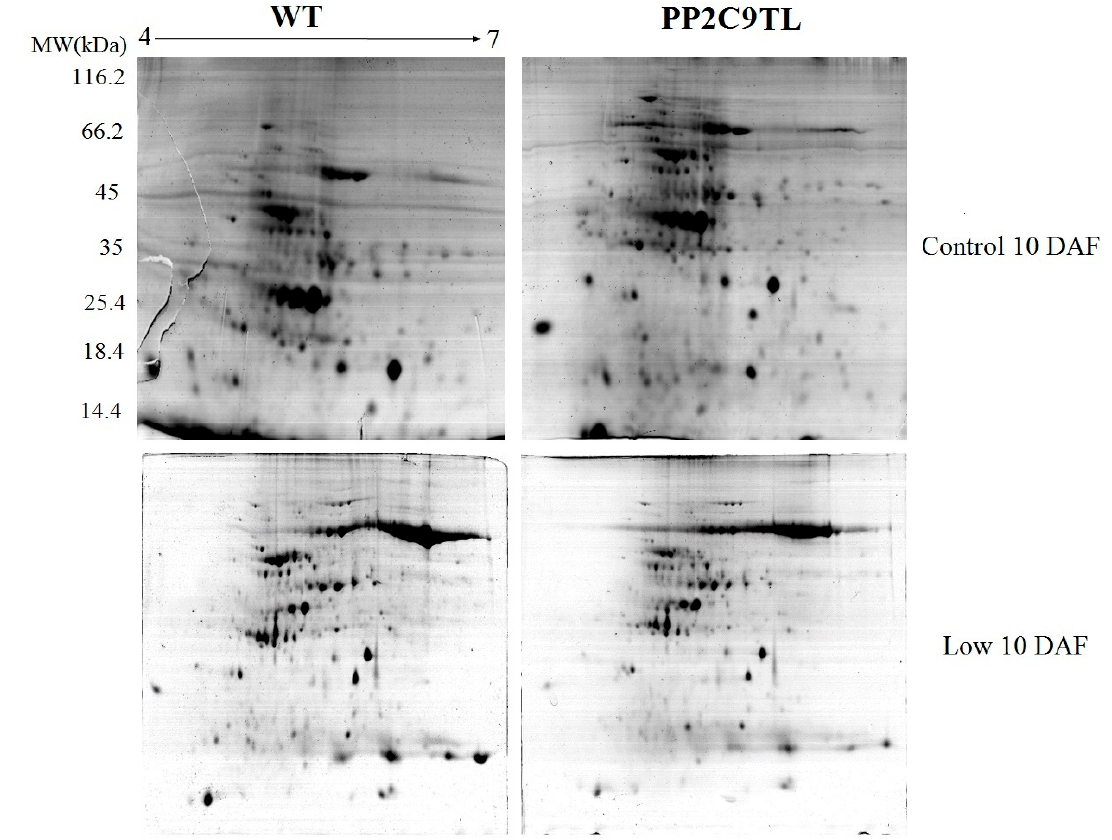
Figure 3. Representative 2-DE gel electrophoresis images of leaf proteins from the WT and PP2C9TL at 10 DAF under control and low N conditions. The MW (kilodaltons) and pI of the proteins are shown on the left and at the top, respectively.